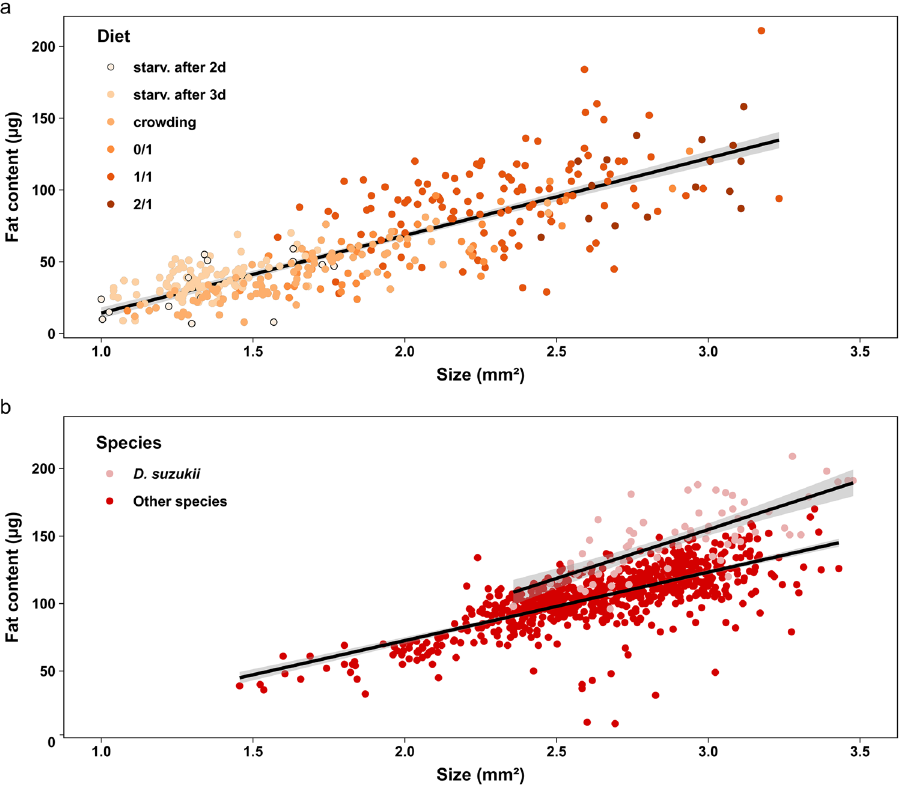
Figure 3. Correlation between pupal size and fat content for laboratory-reared pupae (( a ), N = 375) and wild pupae (( b ), N = 810). Lines represent fitted values from the LMMs and the shaded areas represent standard errors. For wild pupae, two regression lines are shown, because there was a significant interaction between pupal size and species (LMM, χ 2 = 4.13, df = 1, p value < 0.05). Diets: 1/1: standard medium; 2/1: twice the amount of sugar; 0/1: no sugar; crowding: 300 eggs in 1 ml of standard medium; starv.: starvation after 2 (2d) or 3 days (3d) of feeding on standard medium. “Other species” represent pupae collected from banana-bait traps, where several different drosophilids were caught ( D. melanogaster , D. simulans , D. hydei and D. subobscura